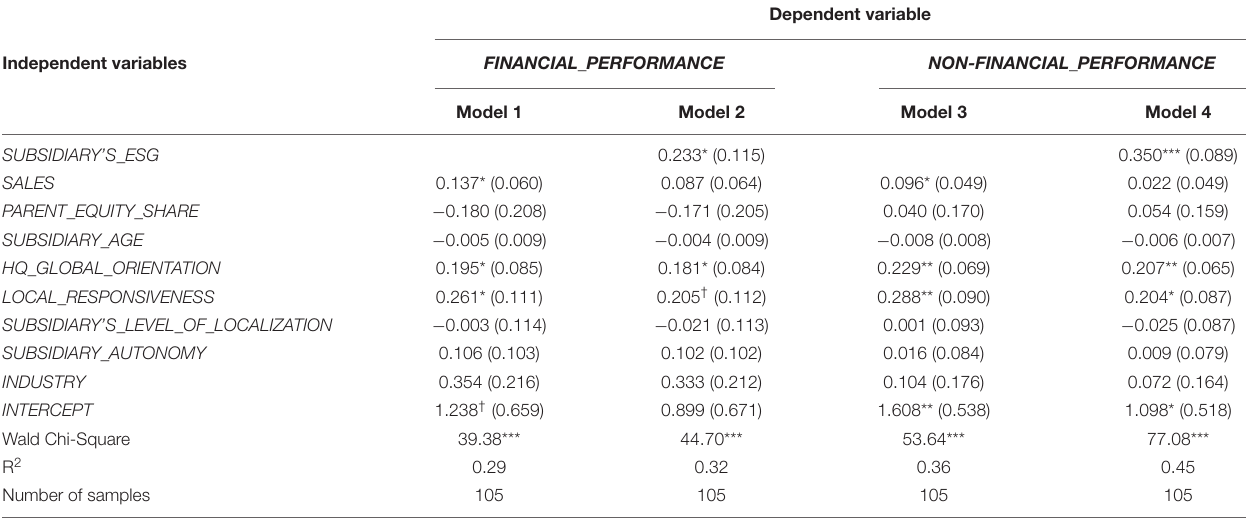
TABLE 4 | The effects of subsidiary’s ESG on financial and non-financial performance.